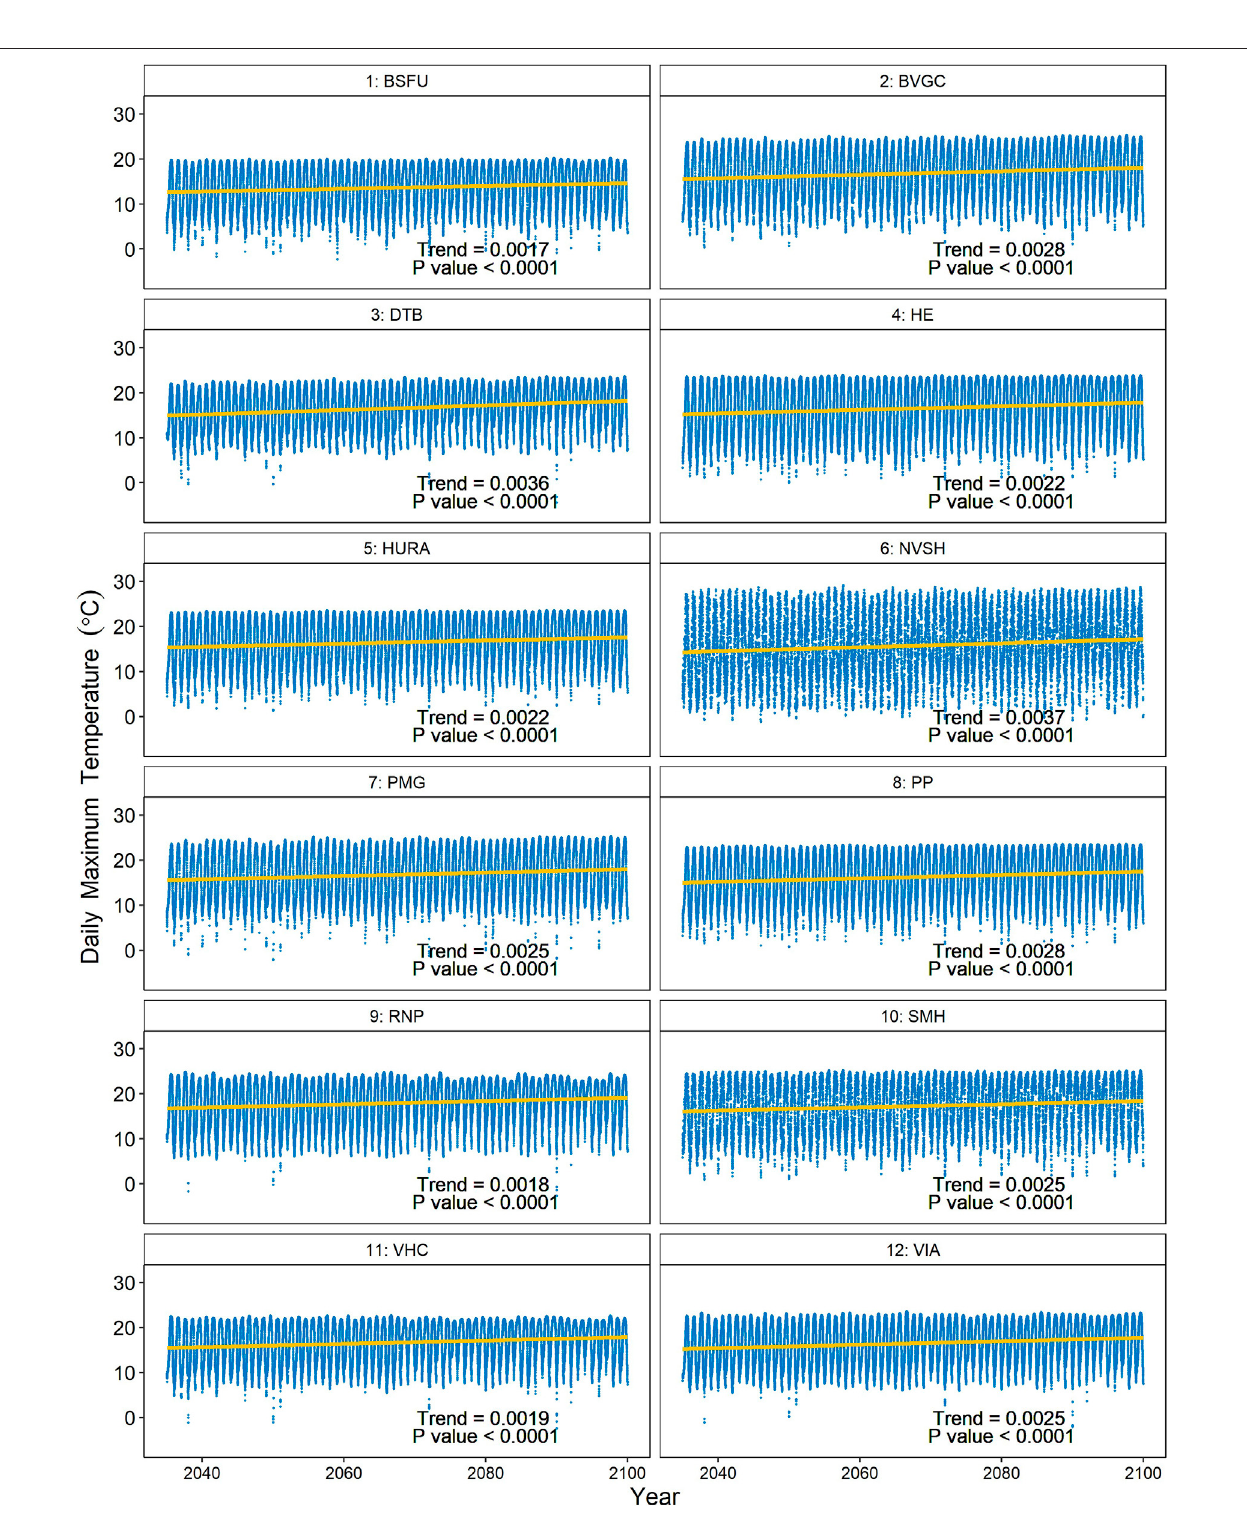
FIGURE 5 | Projected trends of daily maximum temperature between 2035 and 2100.